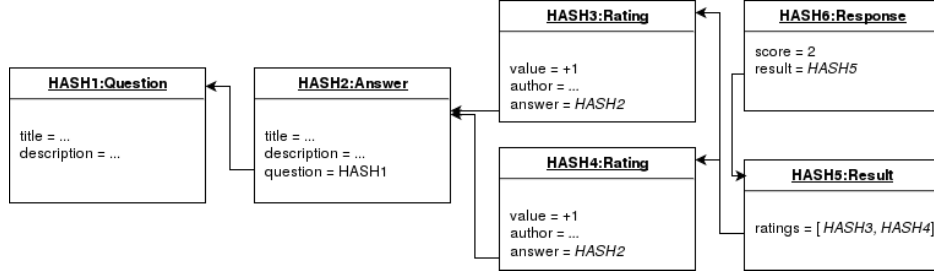
Figure 1. Merkle-linked data of an example Q&A system (such as Stack Overflow).